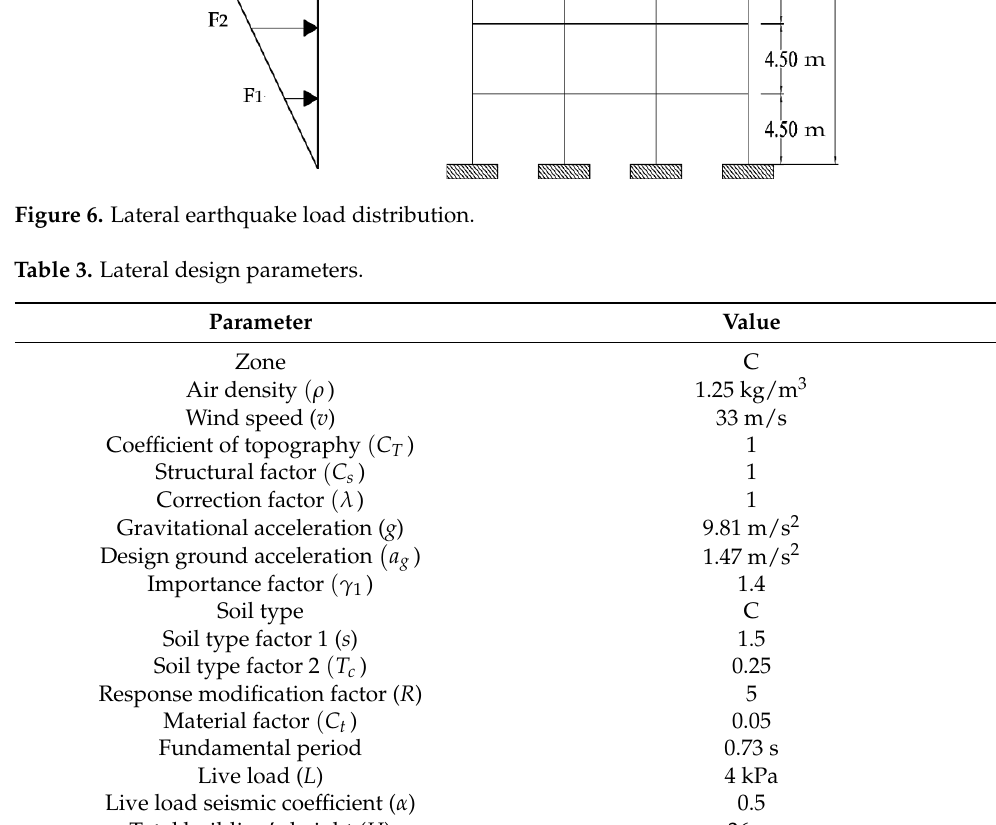
Table 3. Lateral design parameters.